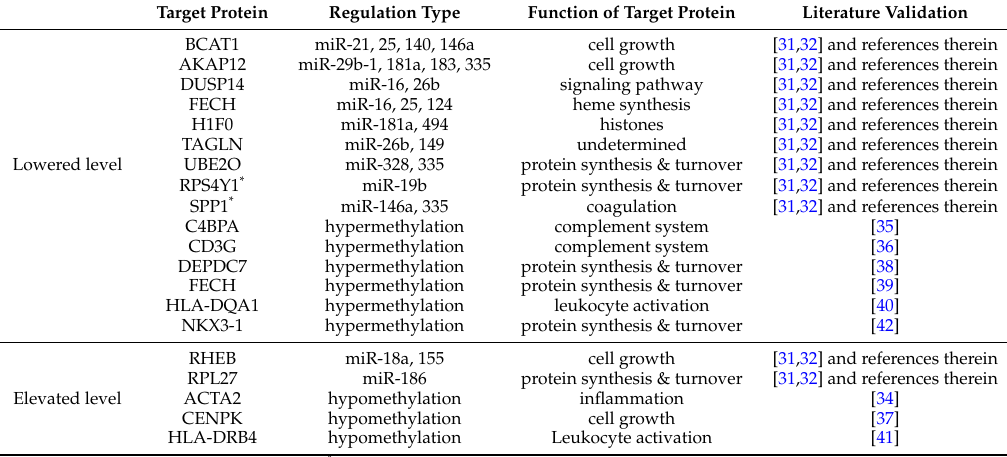
Table 2. Potential miRNA and methylation regulations in early CE stroke pathophysiology.